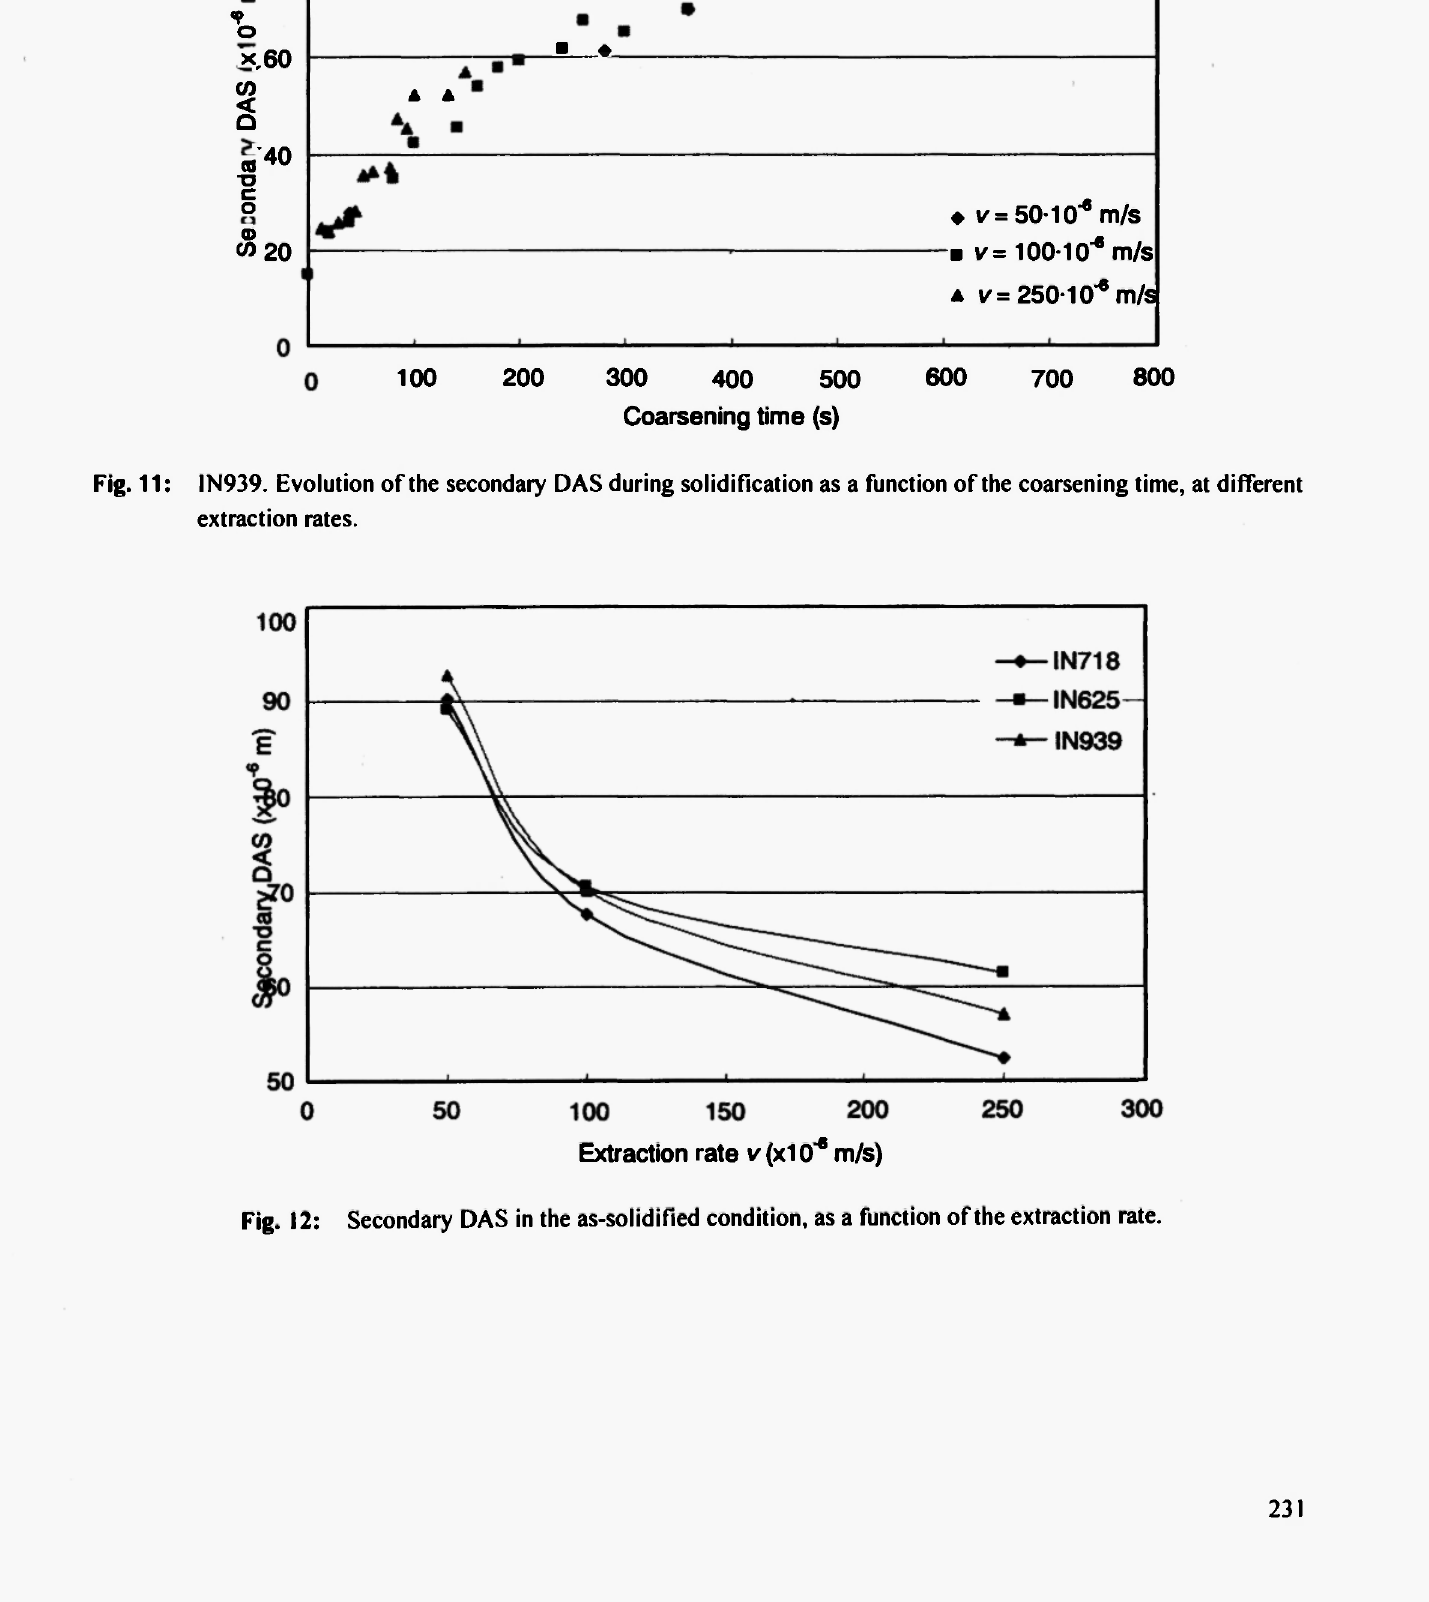
Fig. 11: IN939. Evolution of the secondary DAS during solidification as a function of the coarsening time, at different extraction rates.